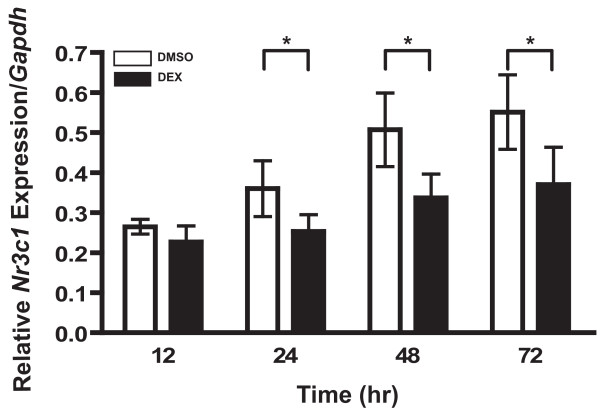
DEX treatments results in down-regulation of Nr3c1 expression. Primary chondrocytes were incubated with DMSO or 10-7 M DEX for 12 to 72 hours, and Nr3c1 mRNA levels were determined by real-time PCR relative to Gapdh. Nr3c1 expression increased under control conditions during the time-course, but decreased upon DEX treatment. Data represent mean ± SEM from three independent trials (*P < 0.05).